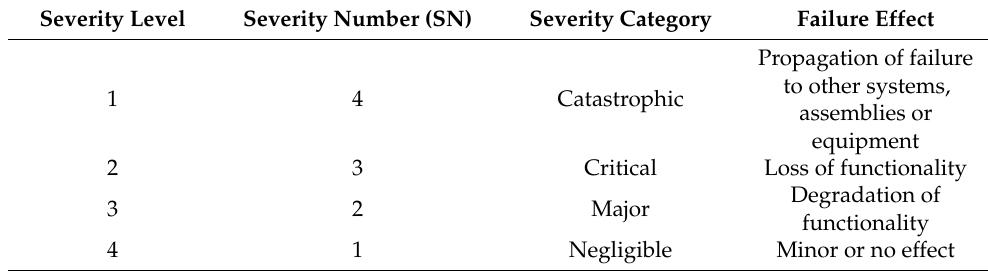
Table 1. Severity numbers (SN) applied at the different severity categories with associated failure ef- fects.